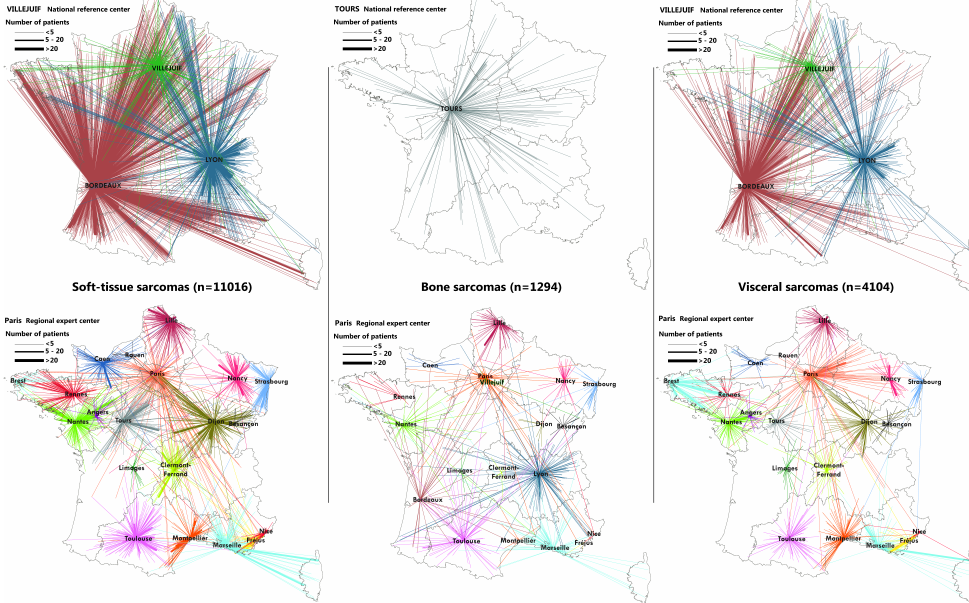
Figure 1 Figure 1. Sarcoma patients’ dwelling place in mainland France (diagnoses between 2011 and 2014) and place of their specimen’s